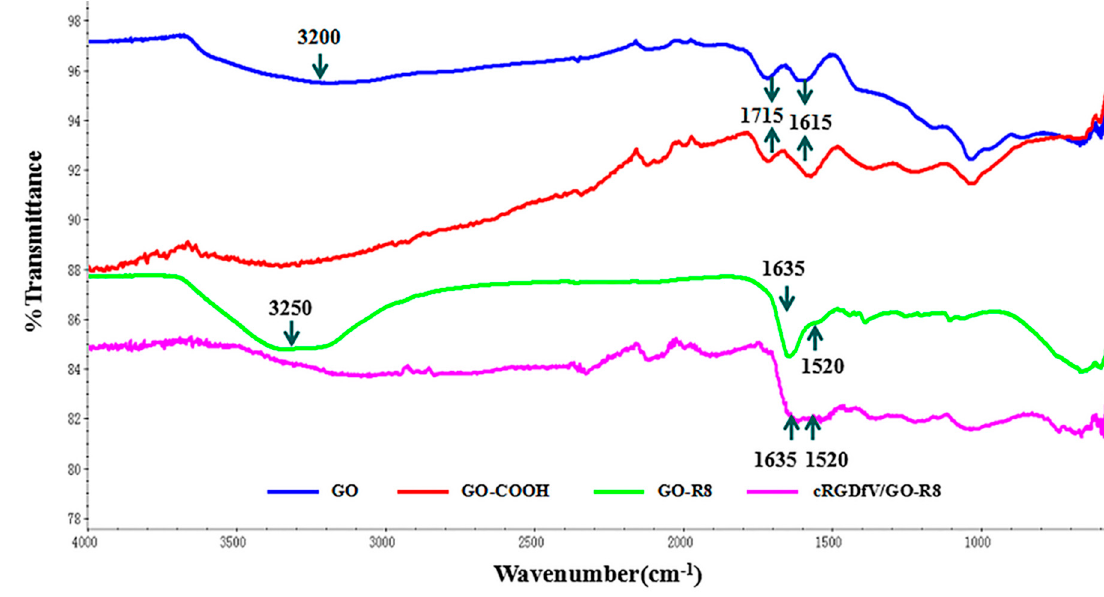
Figure 1. Fourier transform infrared spectroscopy (FTIR) spectra of graphene oxide (GO) (blue), GO-COOH (red), GR (green), and GRcR (purple).